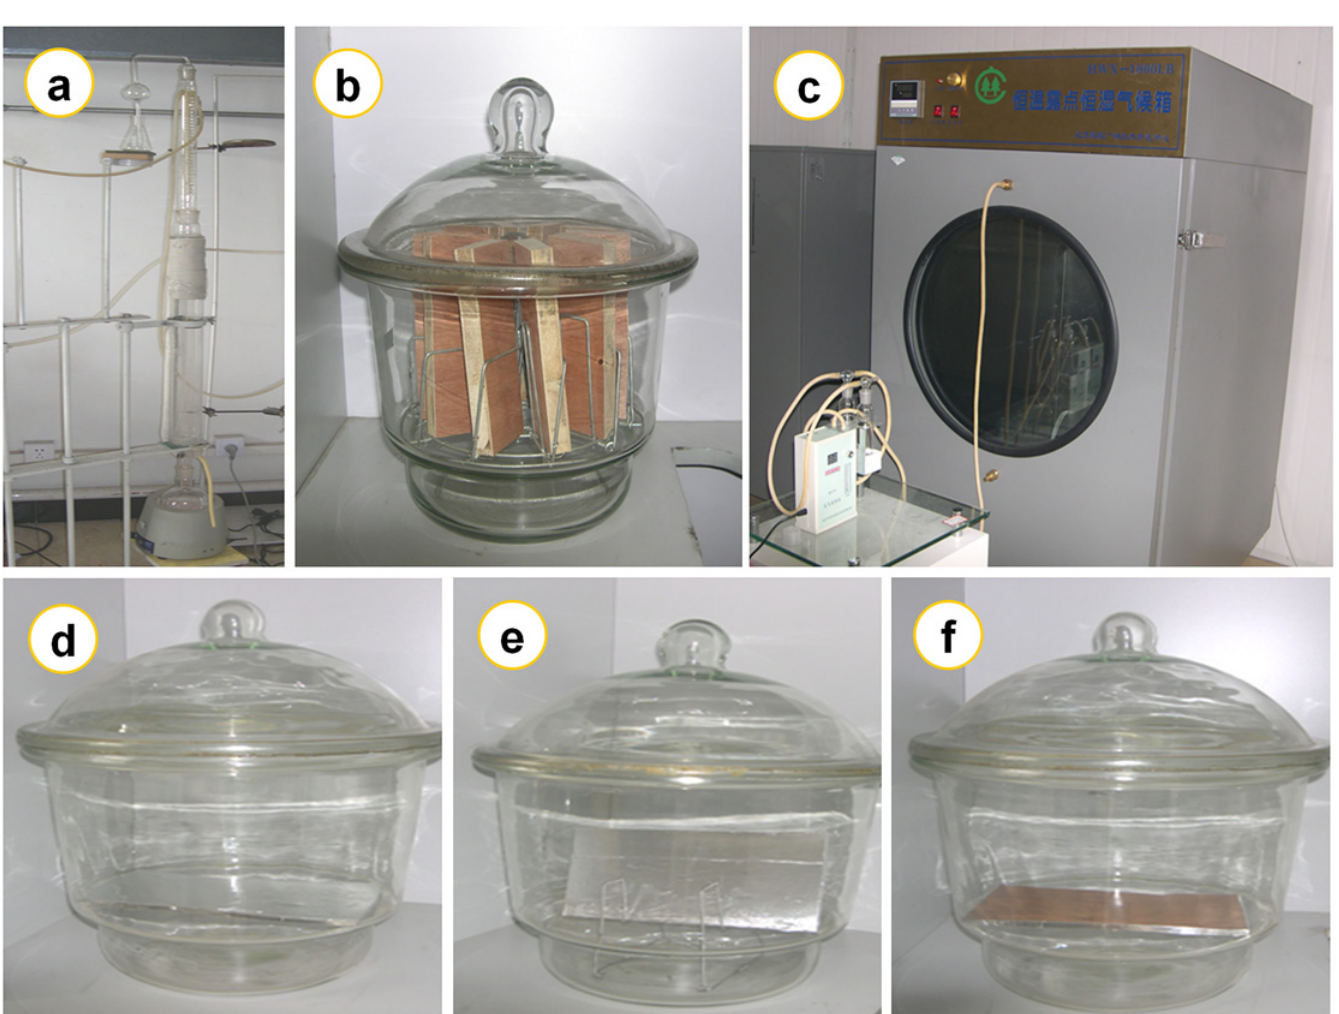
Fig 1. The 4 standard test methods of the Chinese national standard GB 18580 for product formaldehyde emissions. (a) The perforator extraction method. (b) The 9 – 11 L desiccator method. (c) The environmental chamber method. (d) The 40 L desiccator method (Posture A, the 450 cm 2 emission surface of the specimen faced the distilled water at the bottom of the desiccator for sampling). (e) The 40 L desiccator method (Posture B, the 450 cm 2 emission surface of the specimen faced the distilled water with 45°). (f) The 40 L desiccator method (Posture C, the sealed surface of the specimen faced the distilled water). About the consideration of the 3 situations for the 40 L desiccator method, see the corresponding results and discussion for the 40 L desiccator